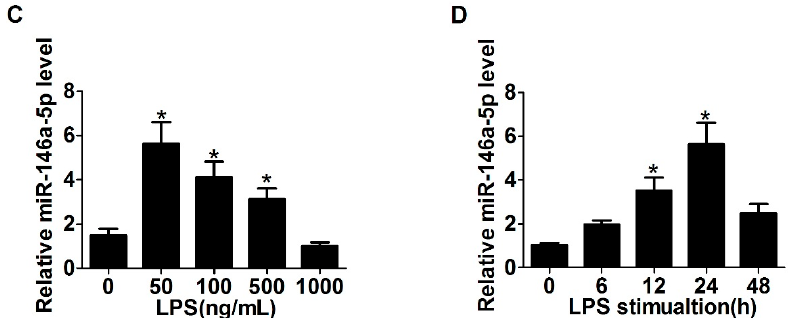
Figure 1. Lipopolysaccharide (LPS) up-regulated toll-like receptor 4 (TLR4) and α -smooth muscle actin ( α -SMA) expression and down-regulated miR-146a-5p expression: ( A , B ) LX2 cells were treated with different amounts of LPS (0~1000 ng/mL) for 24 or 48 h and then quantitative real-time PCR (qRT-PCR) were used to detect the expression of TLR4 and α -SMA; ( C ) miR-146a-5p expression was examined by qRT-PCR after treatment with different amounts of LPS (0~1000 ng/mL) for 24 h; and ( D ) miR-146a-5p expression was assessed by qRT-PCR after treatment with 50 ng/mL of LPS for the various times (0, 6, 12, 24 and 48 h). * p < 0.05 vs. control group.